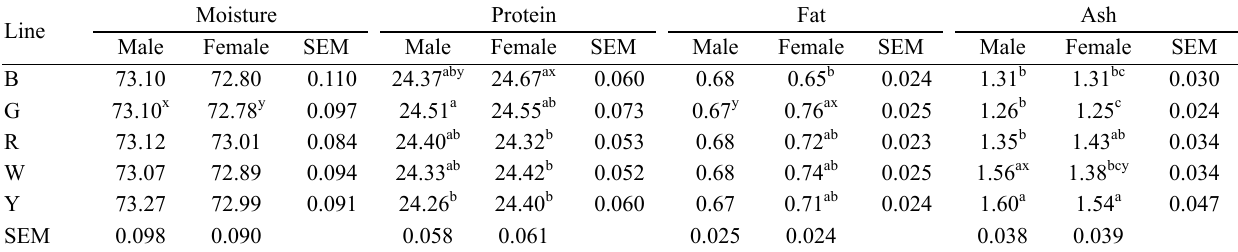
Table 1. Proximate composition (%) of the breast meat from Korean native chicken